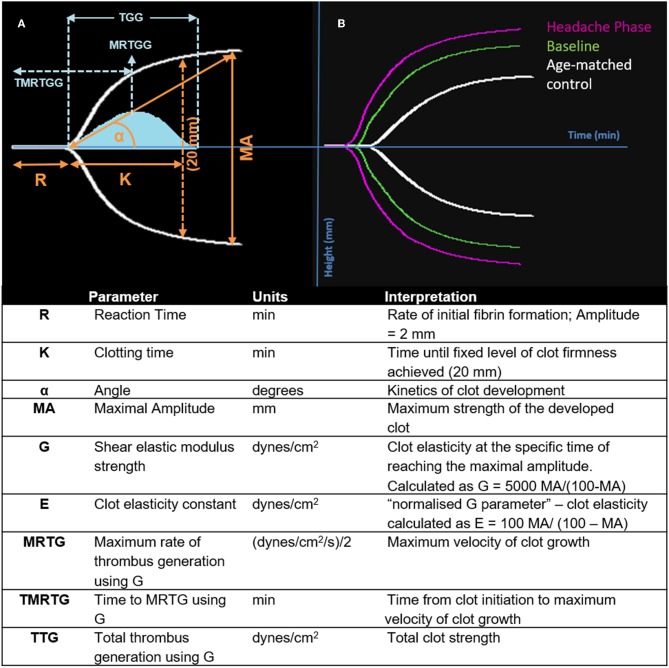
Interpretation of the TEG® tracing (blue in A), velocity curve (blue in B), and parameters produced for FMA at baseline and headache phase compared to age-matched healthy controls. The velocity curve parameters (MRTG, TMRTG, and TTG) are calculated using the G value of the TEG® tracing.